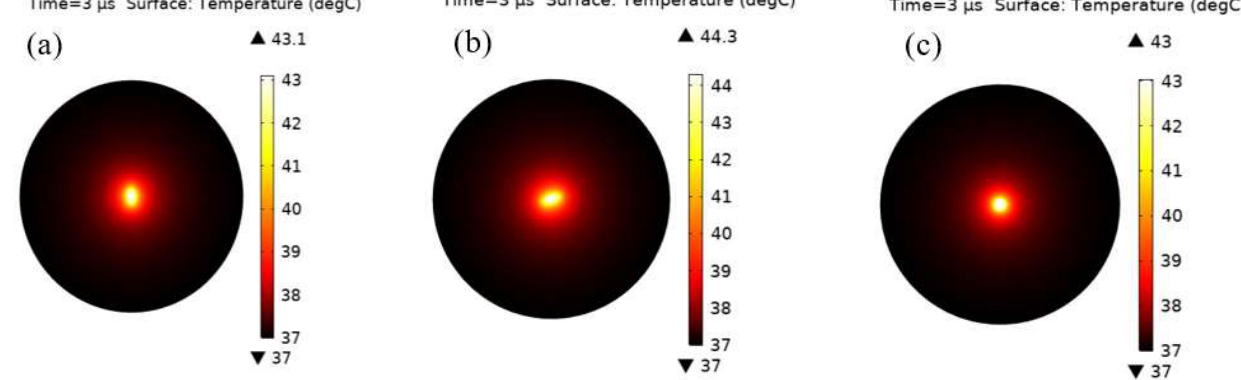
Figure 6. 2D spatial temperature distributions in tumoral cell using ( a ) nano-ellipsoid, ( b ) nanorod and ( c ) nanosphere. The temperature distributions were obtained after 0.5 µm of heating.